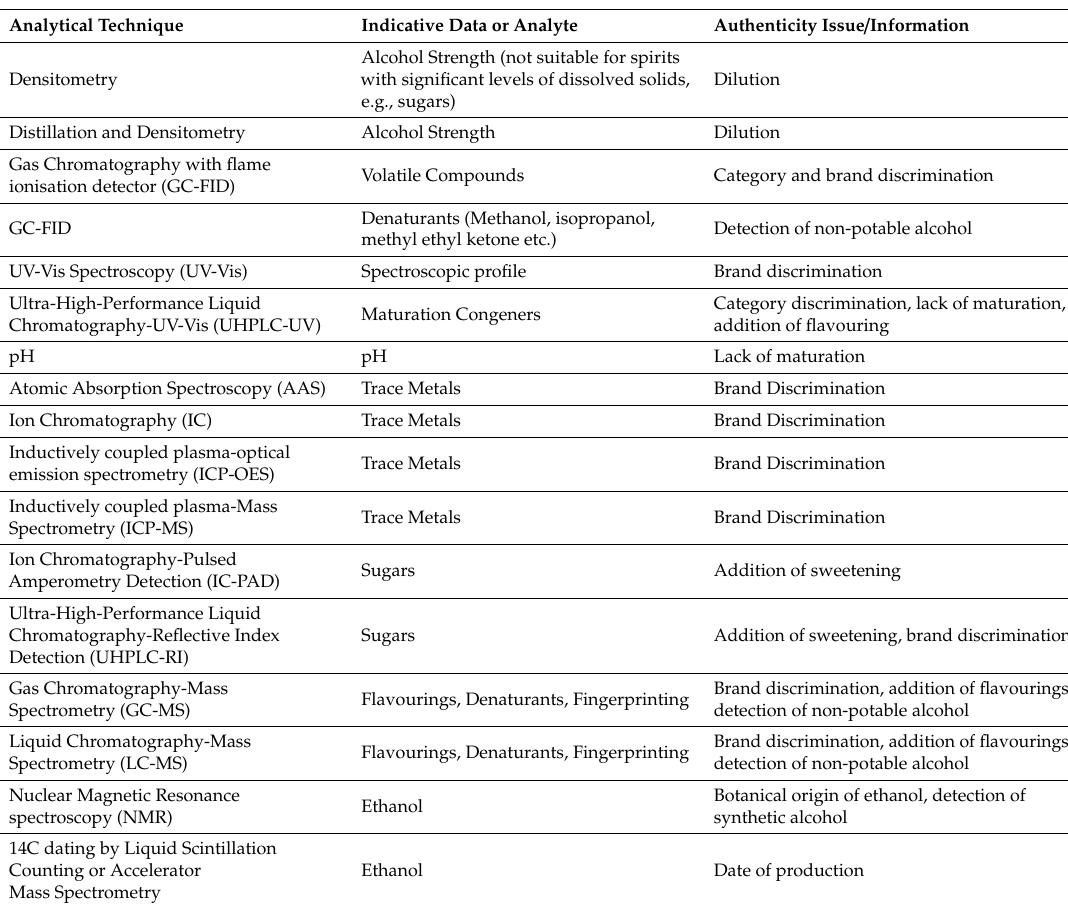
Table 1. Standard analytical methods utilised and their application